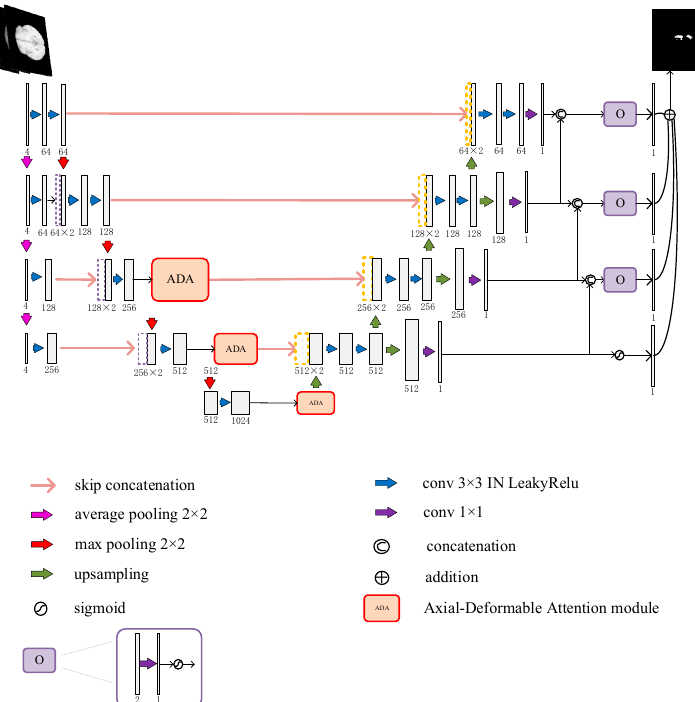
Figure 1. Proposed LGMSU-Net architecture. Numbers 64, 128, 256, and so on indicate the number of feature channels.